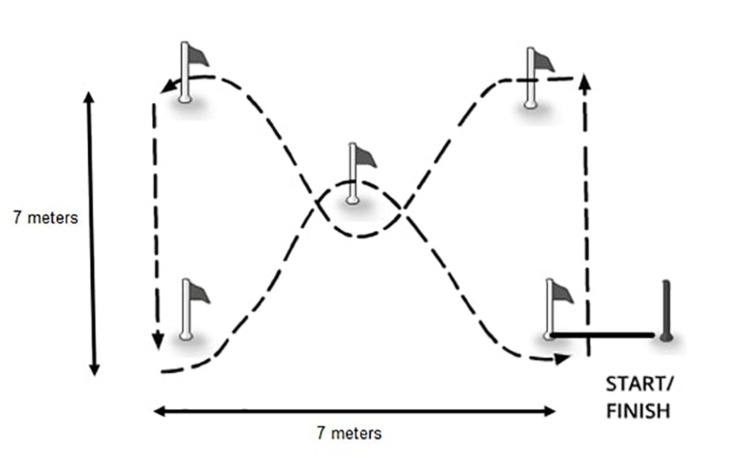
Zigzag agility test.